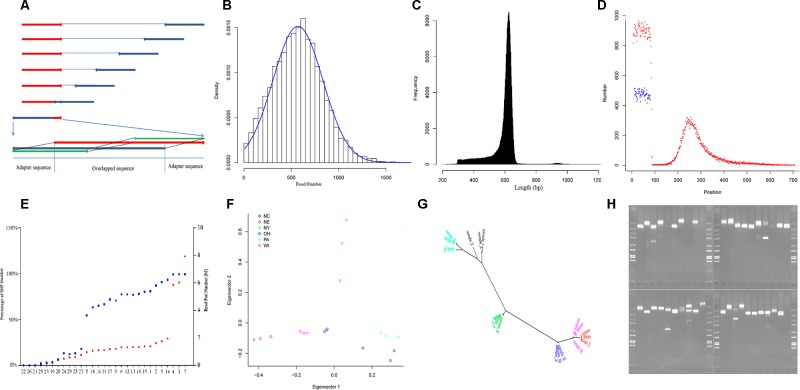
Characteristics of yellow perch RAD-Seq. (A) Illustrating the removal of adaptor sequences at the 3′ end of read. The red arrows show the forward reads, and blue arrows show the reverse reads. Usually, each read contains adaptor sequence at the 5- end and removed routinely. The adaptor sequence would appear in 3′ end when the read length is longer than the library size. Based on the characters of rare Indel and overlapping genome sequence fragment, the 5′ end sequence fragment probe (green) in the forward read (red) was used to scan the reverse read (dark blue) in the direction from 3′ end to 5′ end with a step size of 1 bp. Once the distance fell below a certain threshold value, the sequence fragment located on the 3′ end of the matched sequence fragment was treated as an adapter and then removed. The scan was also applied to the forward read. (B) The read number that clustered for each RAD-tag. The blue line shows the expected distribution fitting Gaussian distribution. (C) The distribution of final contig length. (D) The distribution of SNPs along the contig (red points: SNPs in the first dataset, blue points: SNPs in the second dataset). (E) The percentage of SNP number for each individual in the whole SNPs (blue points, left axis) in the first dataset and read pair number for each individual after removing duplication (red points, red axis). The nine individuals with less than 50% of total SNPs were removed in population genetics. (F) The distribution of the 18 individuals from six strains (
Table 1
) along the first and second principal components. (G) The phylogenetic tree for the same individuals in graph G with the same color schedule. (H) The electrophoretogram for the 40 randomly chosen SSRs. The last second lane on the right-down figure is negative control without primer inside.